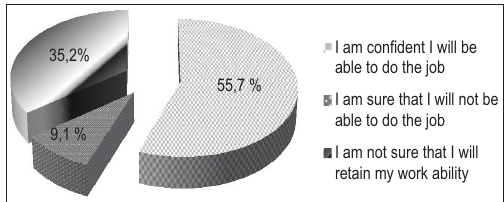
FIGURE 2. Health professionals’ perceptions of working ability over the next 2